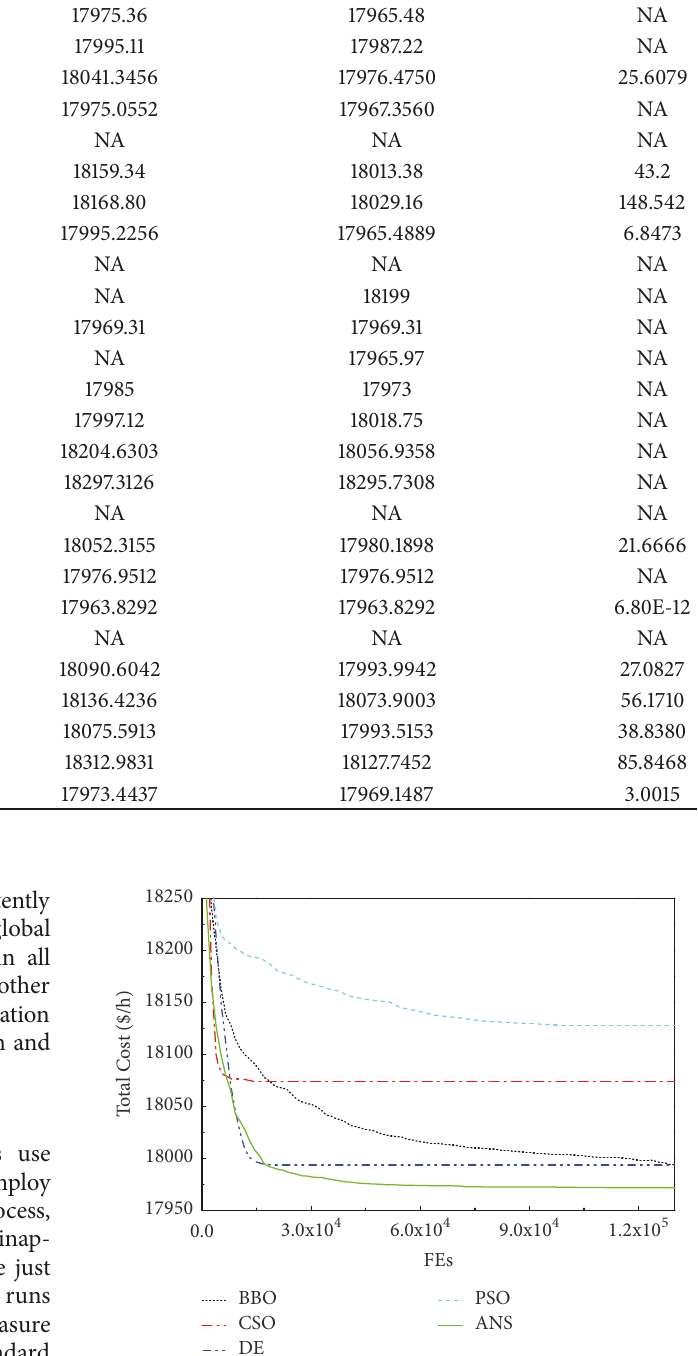
Figure 2: Convergence curves for the 13-generator system (Case I). stable optimal result in each trial. In addition, through careful observation, we can see that the standard deviation values of Cases I and IV are bigger than those of Cases II and